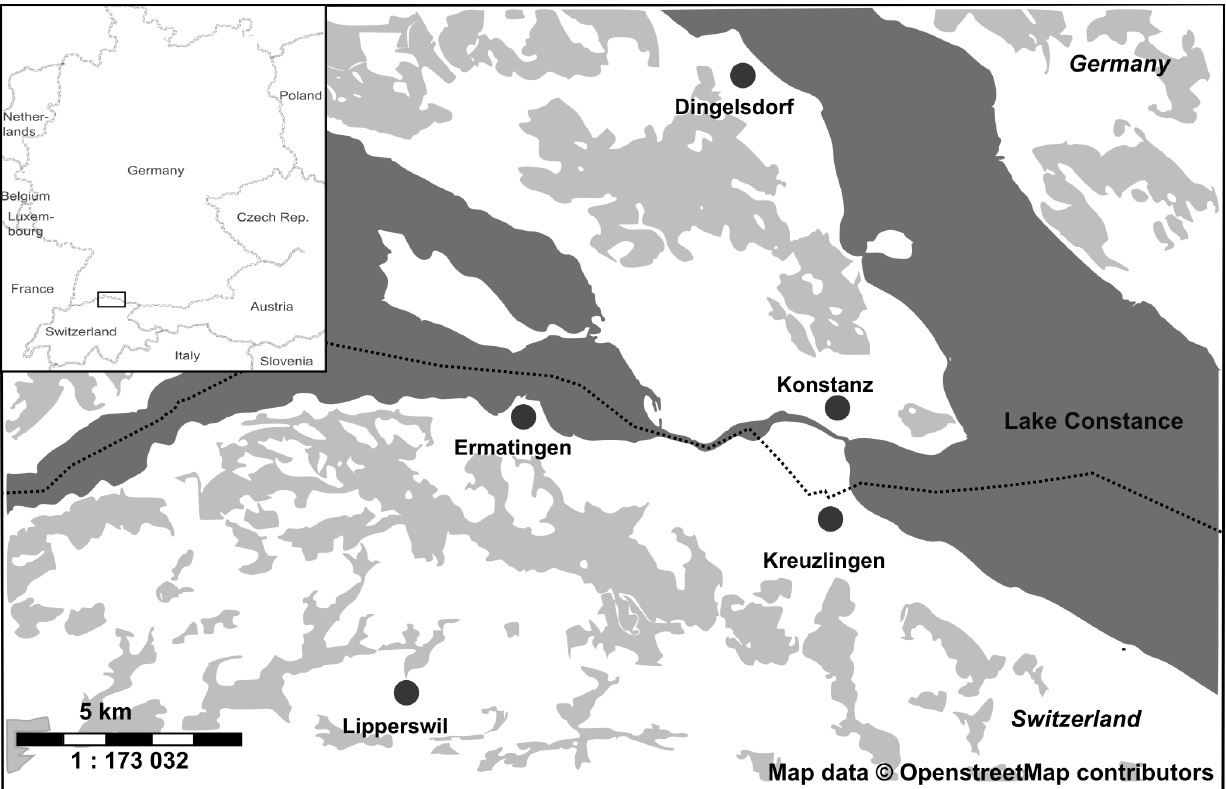
Figure 1. Map of sampling locations. Map of faecal sampling locations (solid circles) for Myotis myotis (Ermatingen and Lipperswil), M. mystacinus (Dingelsdorf) and M. daubentonii (Kreuzlingen). In the top left the broad sampling area is marked in a box (modified from (cid:2) OpenStreetMap contributors).